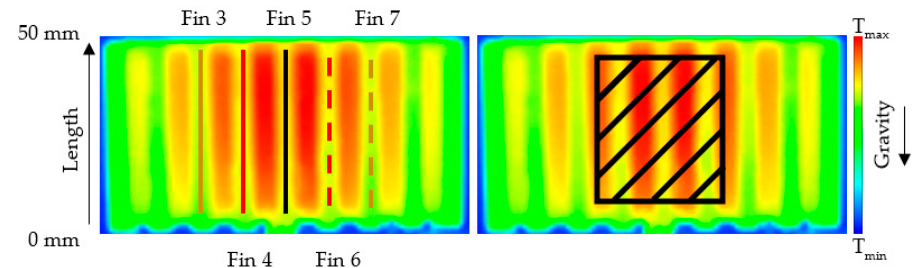
Figure 10. Heater placement in regard to the fins’ positions.